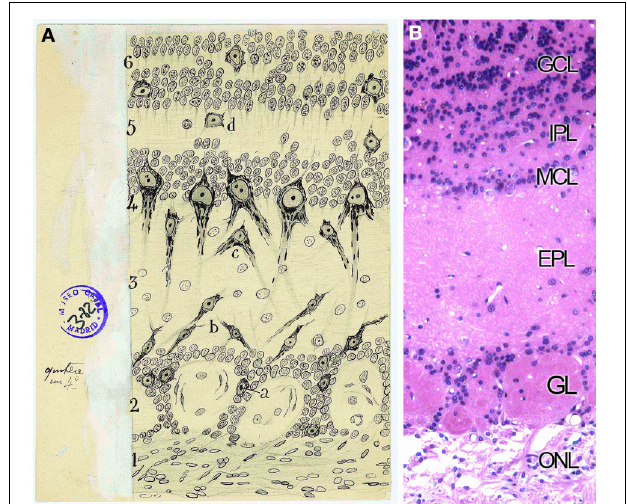
FIGURE 5 | Layers distribution of the Olfactory bulb. (A) Original Cajal drawing of the frontal section of the rabbit olfactory bulb (Ramón y Cajal, 1901). (1) Nerve layer (ONL). (2) Glomerular layer (GL). (3) External plexiform layer (EPL). (4) Mitral cells layer (MCL). (5) Inner plexiform layer (IPL). (6) Grains and white matter layer (GcL). (a) Peripheral tufted cells; (b) middle; (c) internal (d) short axon cells. Cajal Legacy (Instituto Cajal, CSIC, Madrid, Spain). (B) Olfactory bulb mouse coronal section of hematoxylin and eosin nuclei staining showing the different layers described by Cajal in (A)